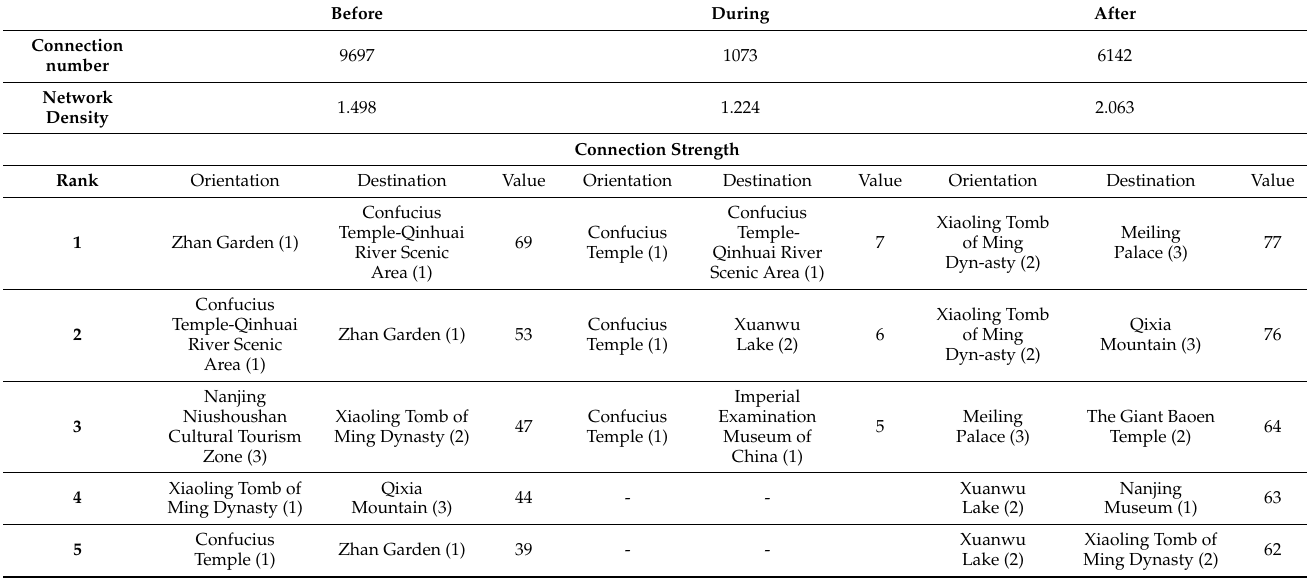
Table 4. Node connection strength and the top five high-connection travel